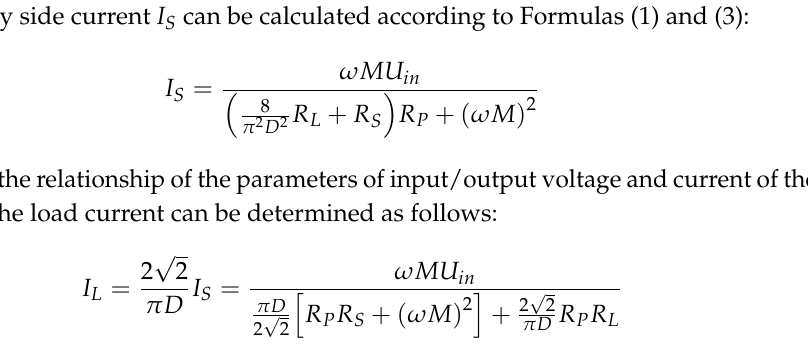
Figure 4. The relationship between D and I L .